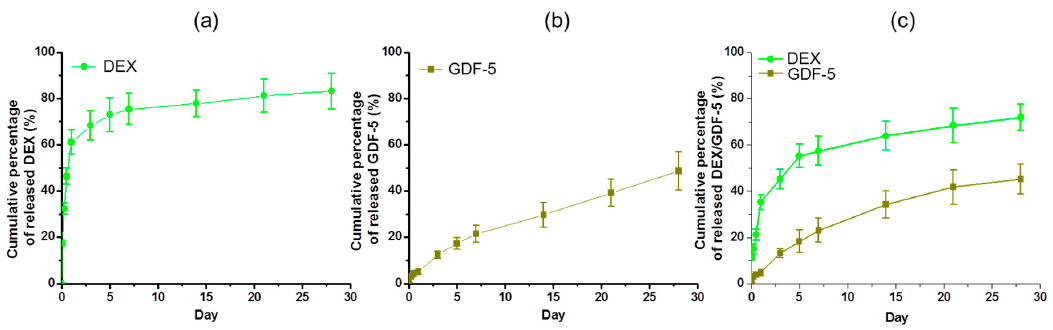
Figure 4. Release behavior of DEX and/or GDF-5 on ( a ) DEX–Ti, ( b ) GDF-5–Ti and ( c ) DEX/GDF-5–Ti disc samples in PBS (pH 7.4) monitored for 28 days. The error bars represent mean ± SD ( n = 3). This experiment was repeated three times.